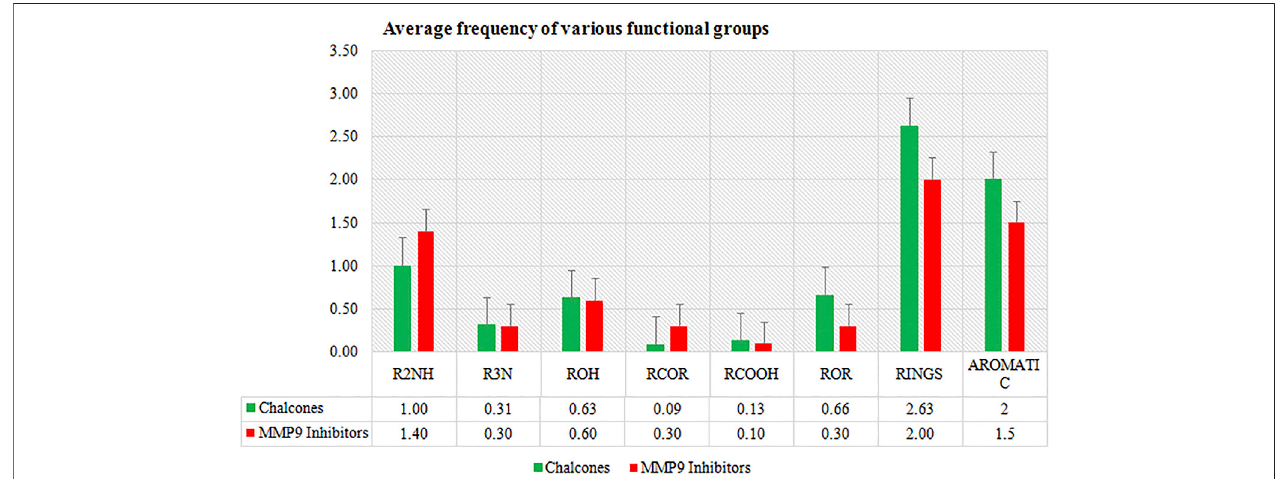
FIGURE 10 | Average frequency of functional groups of MMP-9 inhibitors and top four compounds.